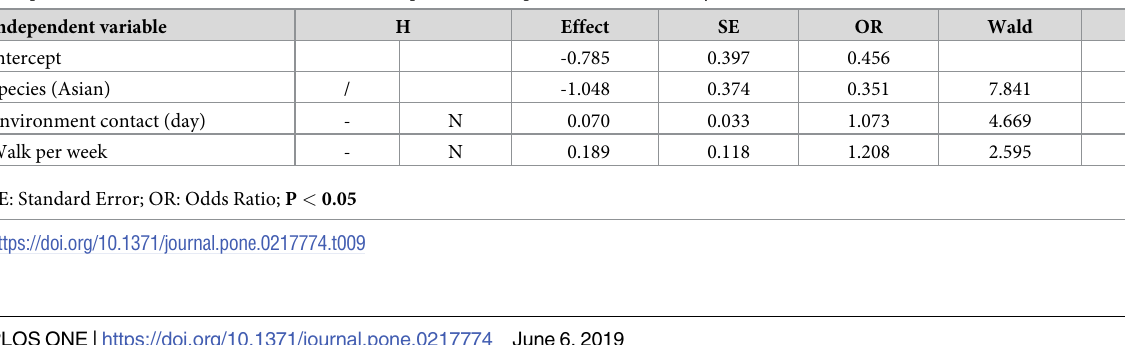
Table 9. Multivariate assessment of the occurrence of gastrointestinal events by binomial regression, counting each animal as having experienced (n = 89) or not (n = 123) this type of pathology. Hypotheses (H): positive (+) or negative (-) relationship of each variable with the occurrence of clinical events per animal as a measure of elephant welfare, and whether observed relationships were in the predicted direction (Y yes / N